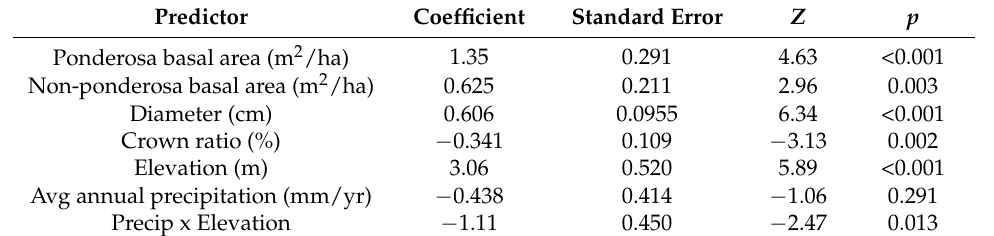
Table 1. Output from the final model containing all significant stand- and tree-level variables and significant interactions with climate variables. Prior to modelling, variables were scaled by subtracting the mean and dividing by the standard deviation, so the coefficient can be interpreted as the change in log odds of mortality resulting from a one-standard-deviation increase in the predictor. Predictor Coefficient Standard Error Z p Ponderosa basal area (m 2 /ha)